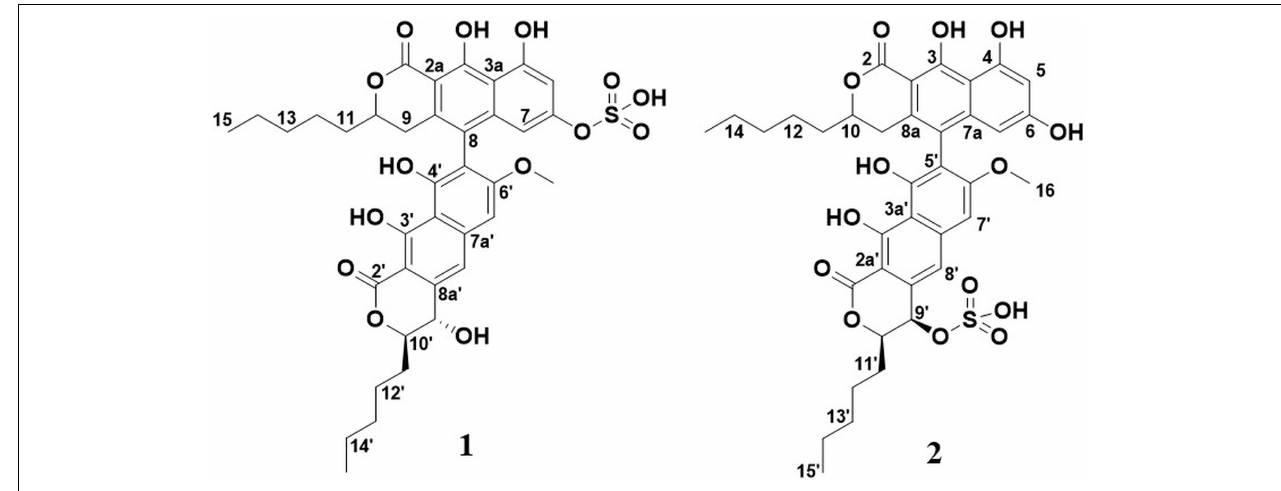
FIGURE 2 | Structures of 1 and 2